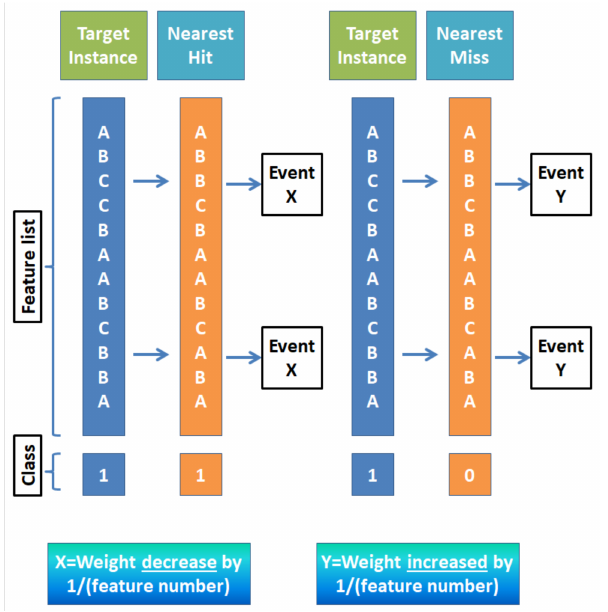
Figure 8. An example of feature weight update procedure based on distance target